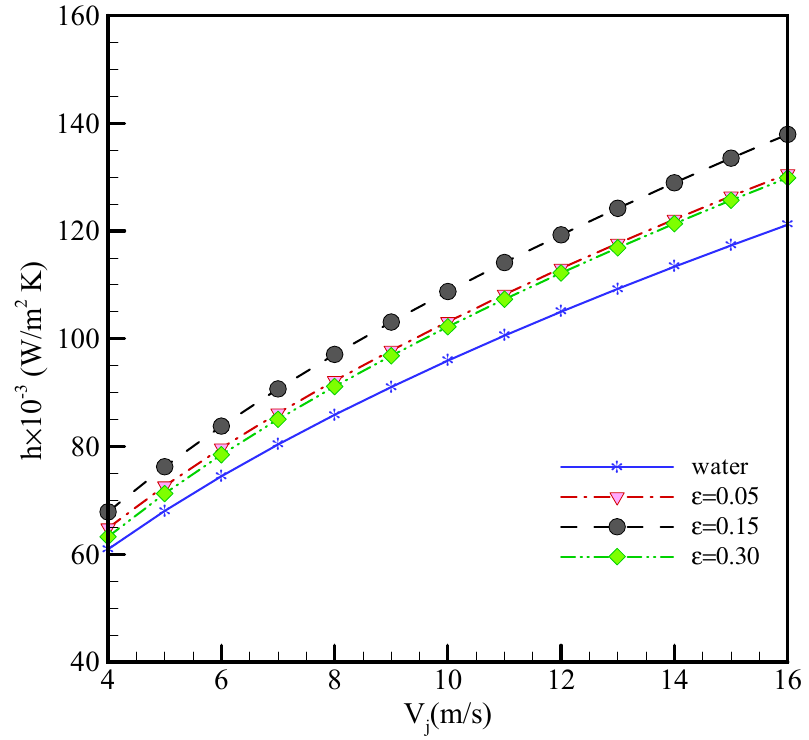
Figure 9. The variation of heat transfer coefficients with respect to jet velocity for NEPCM slurry with different particle volume fraction when the inlet jet temperature is set at 25 ◦